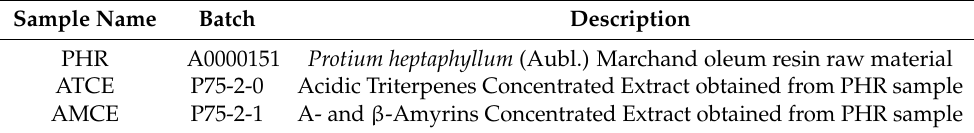
Table 5. Sample list and